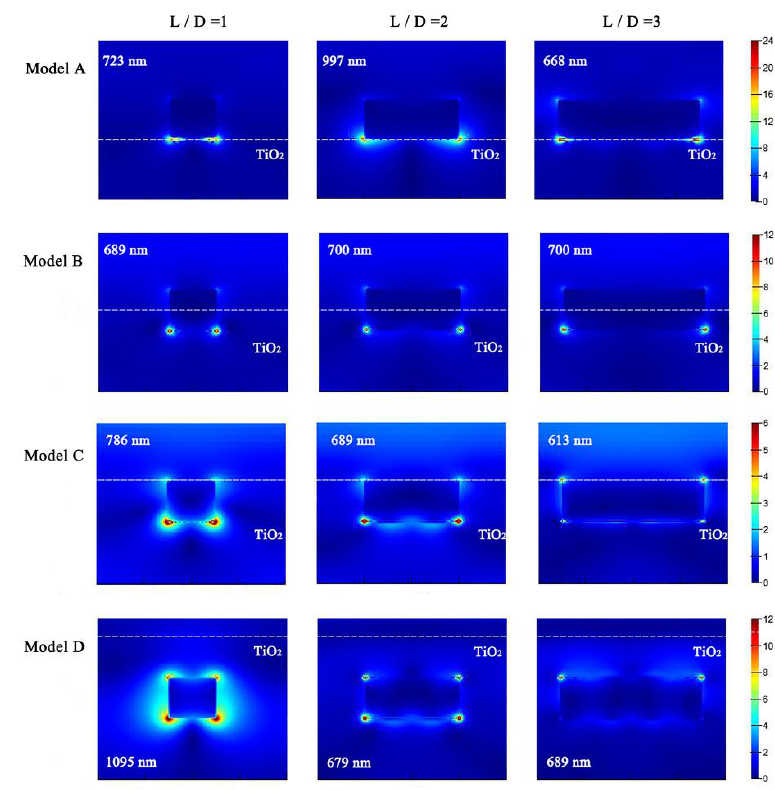
Figure 9. The distribution of the strongest local enhanced electric field of Au nanorods loaded on the TiO 2 substrate in the whole simulation region of 300–900 nm. The dashed line represents the interface between Au nanorods and the TiO 2 substrate.